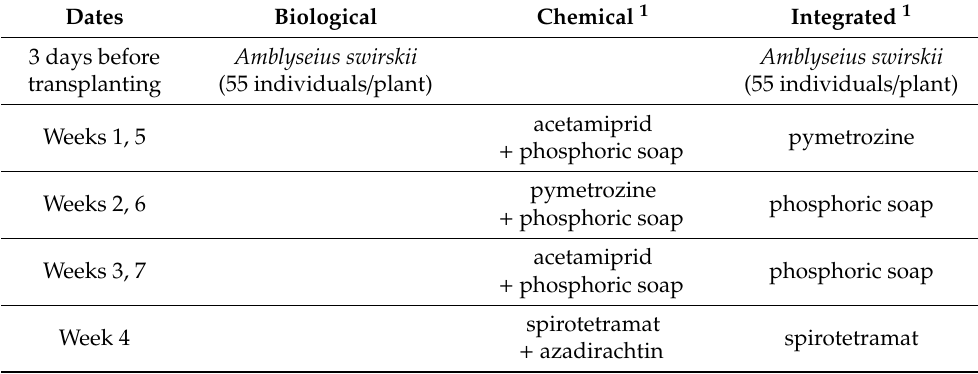
Table 1. Biological, chemical, and integrated treatment schedule applied in the experimental greenhouse